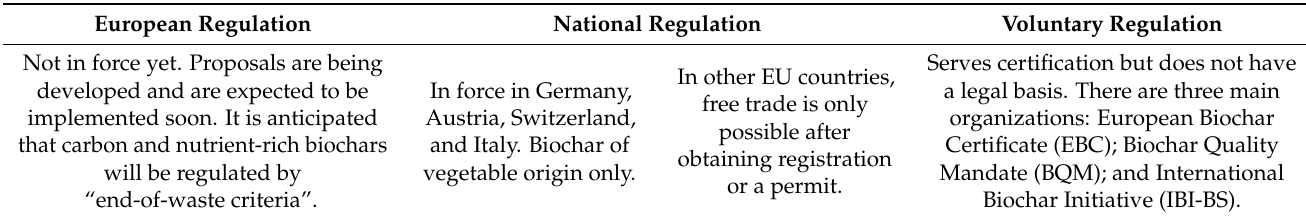
Table 7. Current regulations on biochar